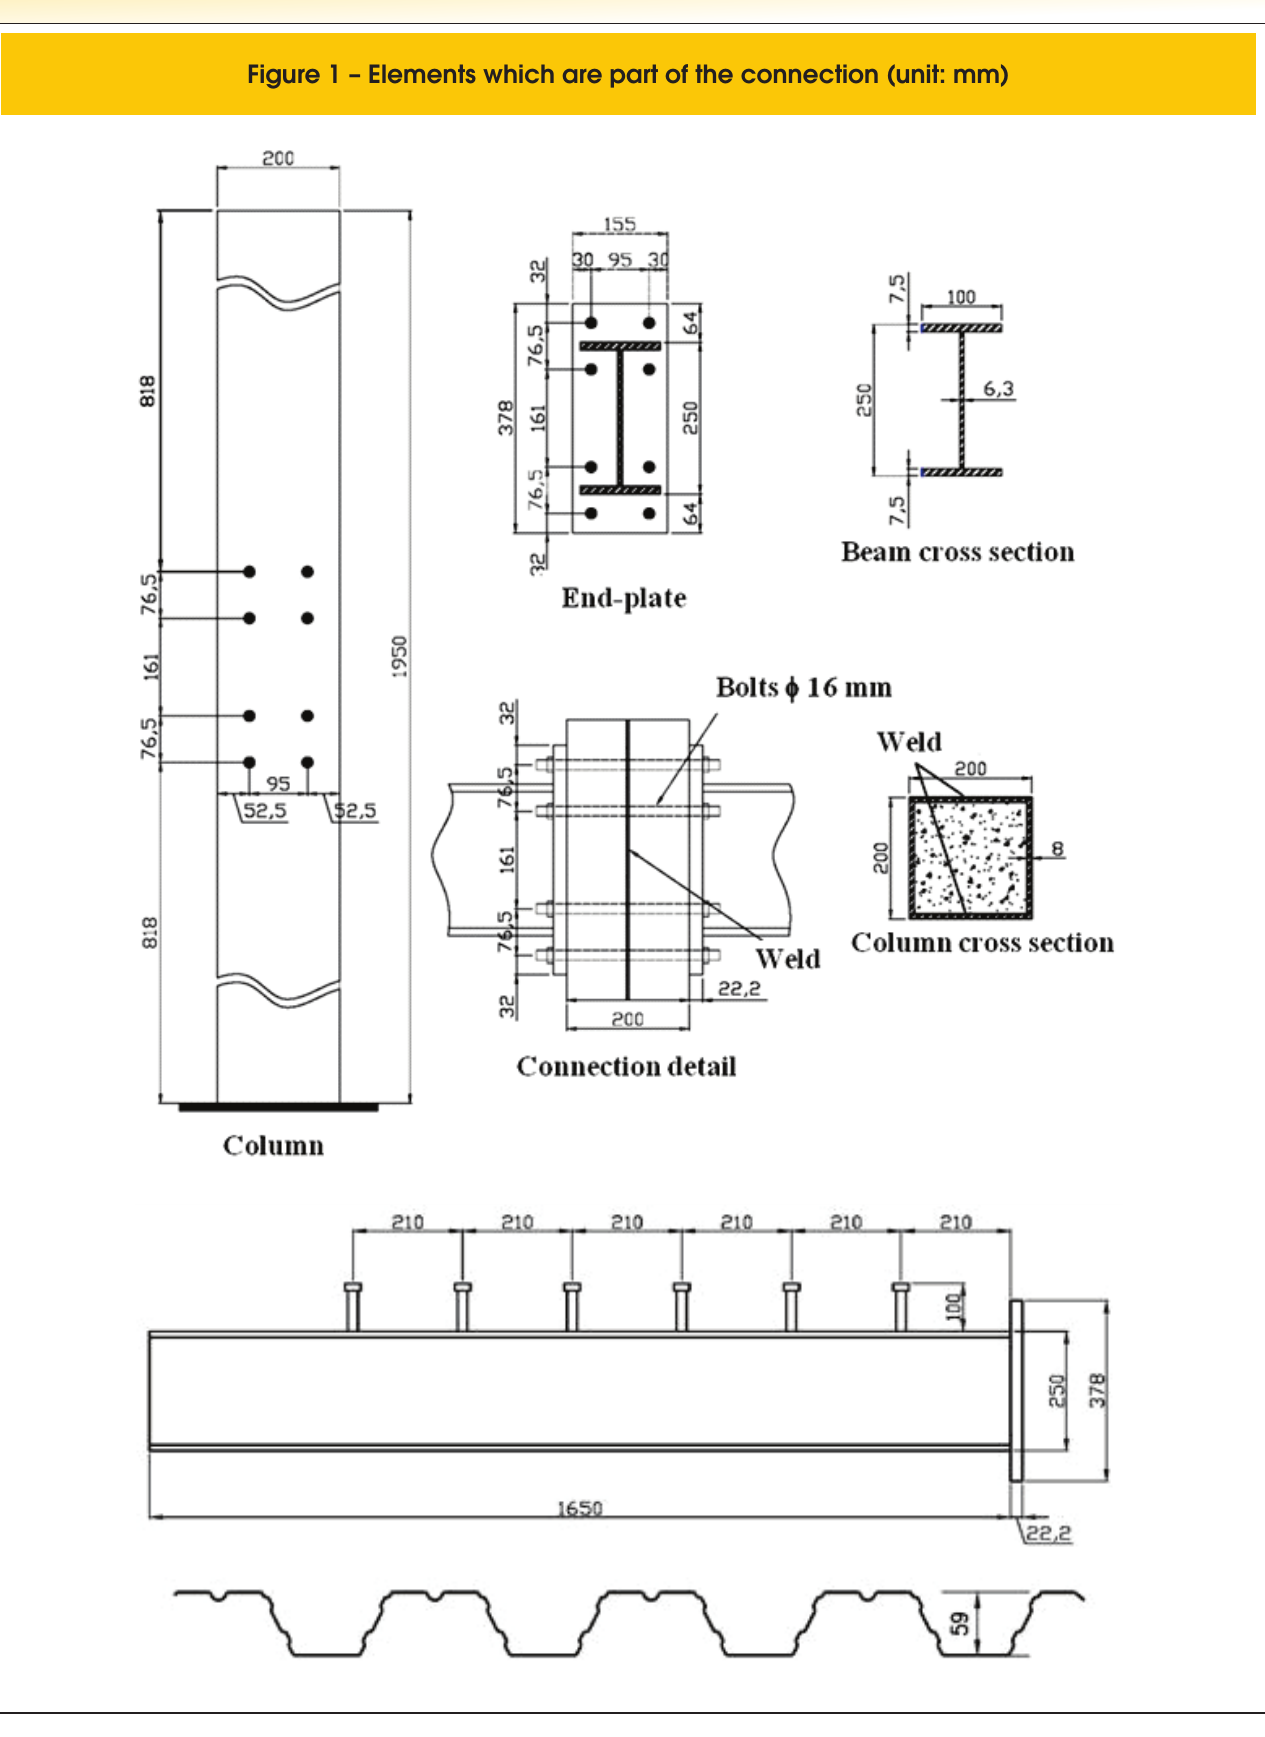
Figure 1 – Elements which are part of the connection (unit: